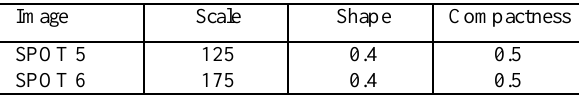
Table 2. Segmentation parameters for SPOT 5 and SPOT 6